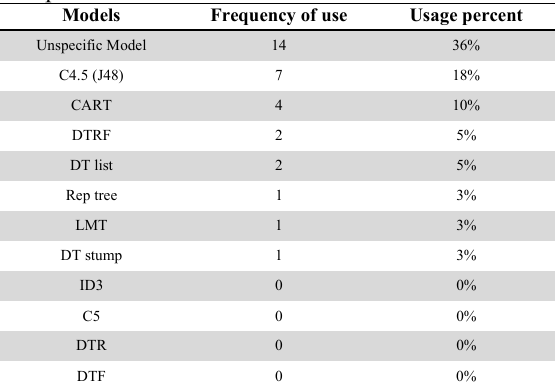
Comparison of the Decision Tree models